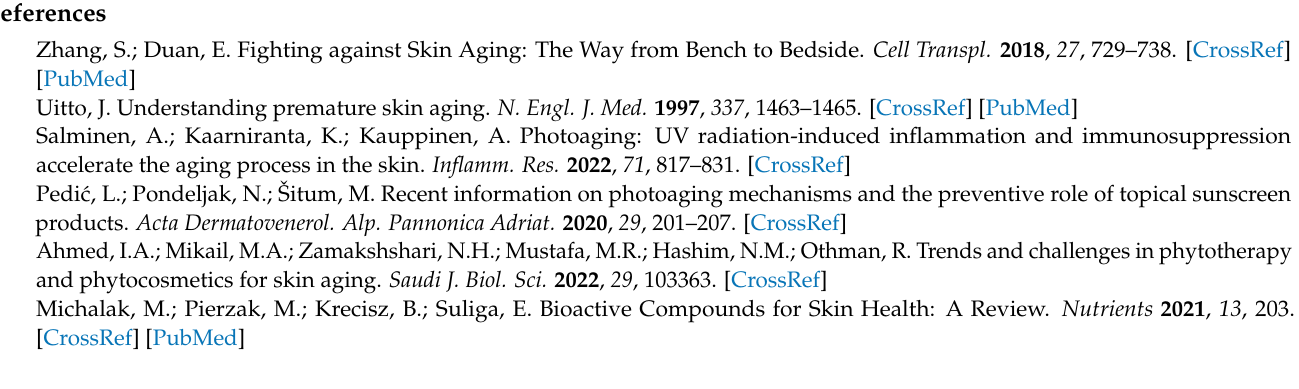
Table S2: Oligonucleotide sequences used in the present study; Figure S1: Identification of UAE by high-performance liquid chromatography (HPLC); Figure S2: TGF-b1 , p38 MAPK , and AKT mRNA expression levels in dorsal back skin tissues were quantified by real-time